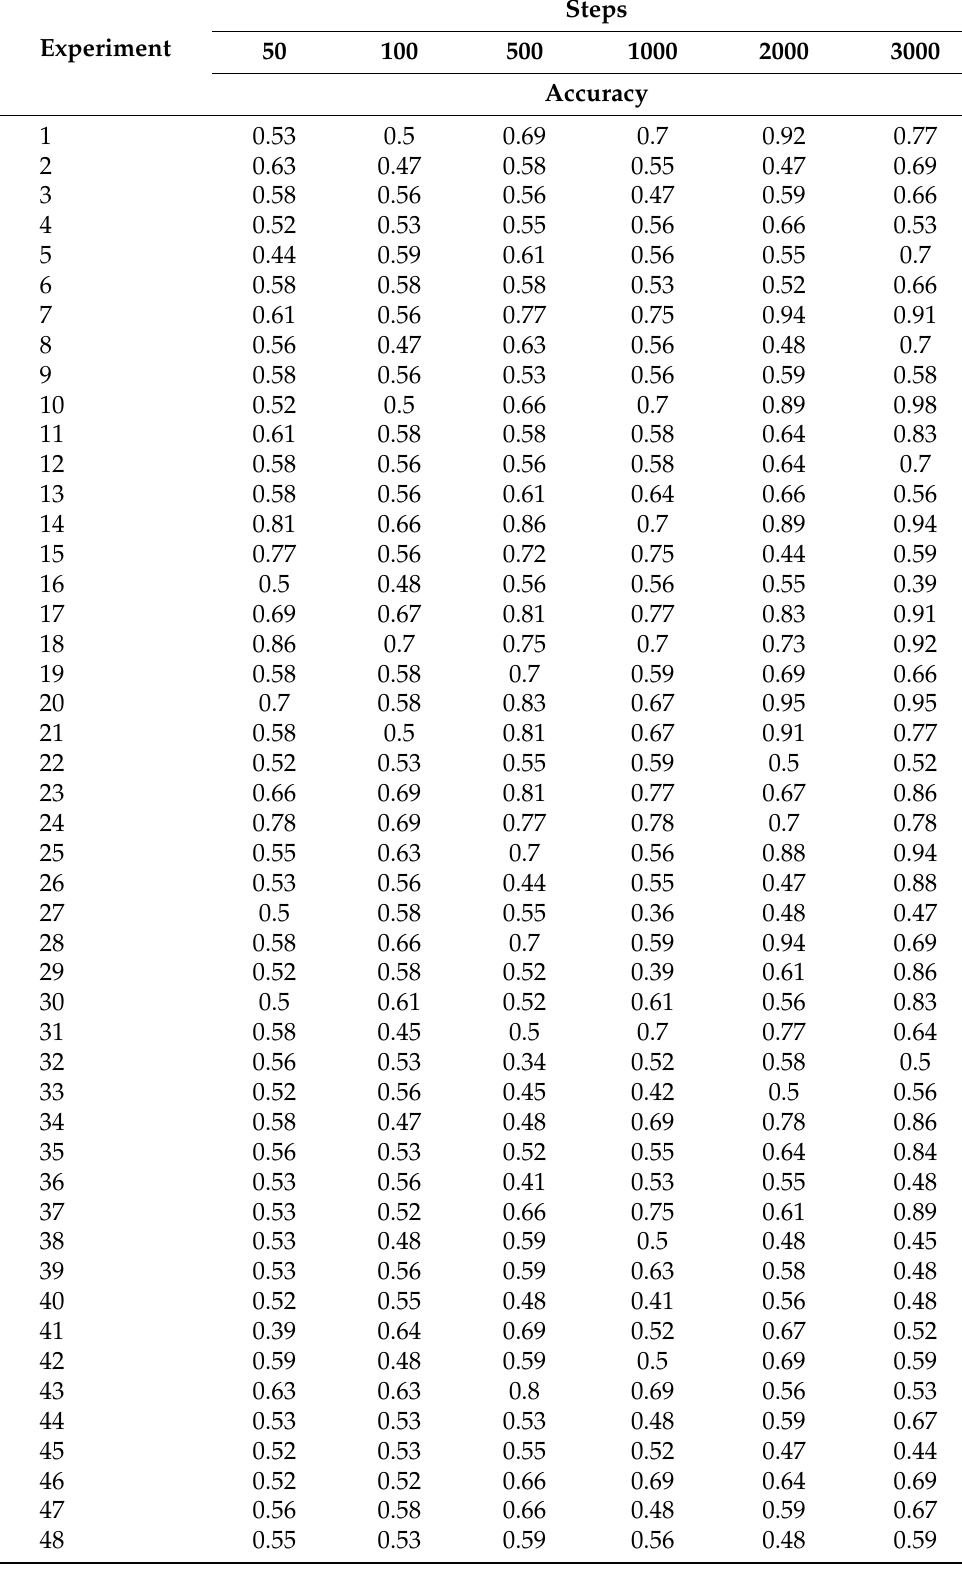
Table 7. Accuracy performance under the occupancy, revenue and vehicle flow regulation (uni- fied)